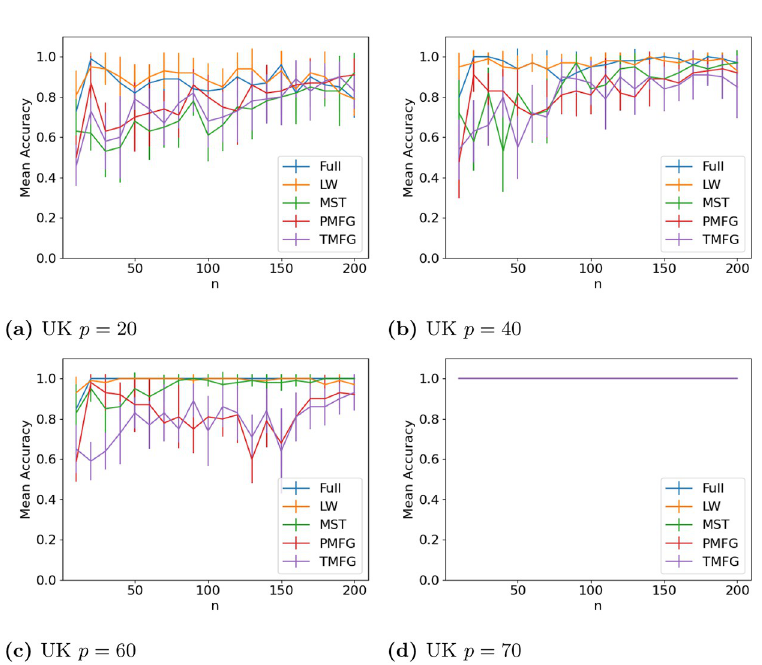
Fig 11. Accuracy when distinguishing between correlation matrices created from the stock windows with the maximum and minimum volatility using the SF method and a random forest classifier for UK stock returns. (a) UK p = 20, (b) UK p = 40, (c) UK p = 60, (d) UK p = 70.